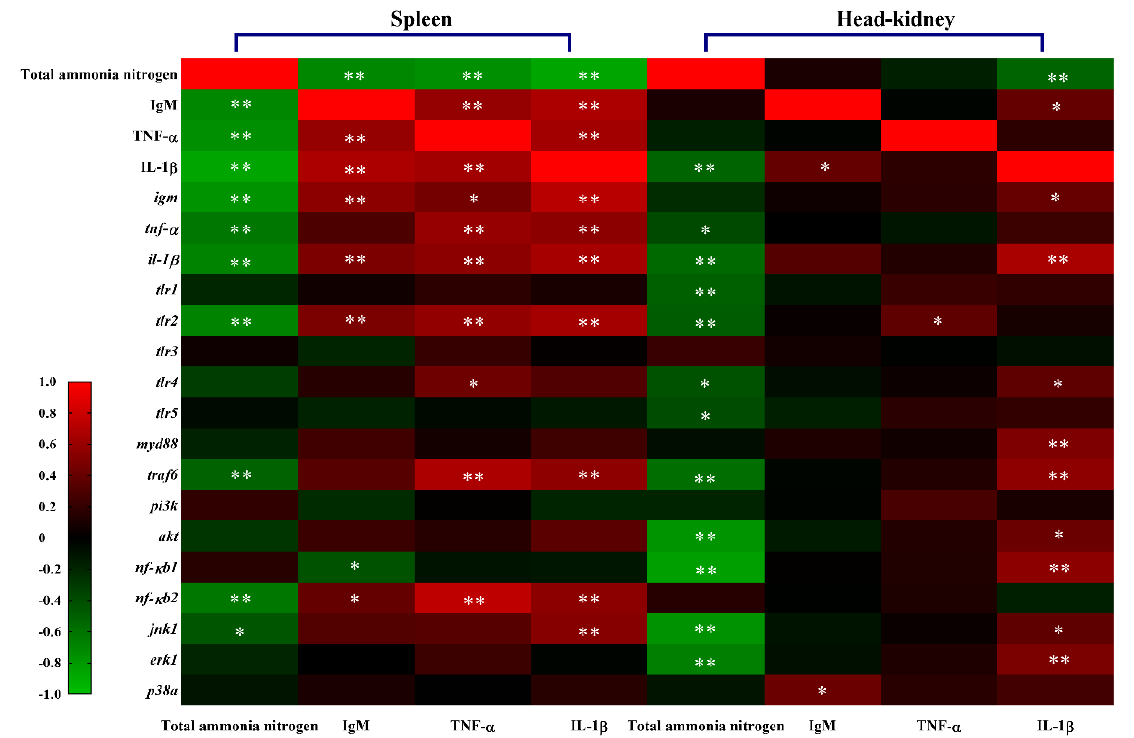
Figure 7. Spearman correlation coefficients ® among ammonia exposure concentration and immune parameters involved with TLR signaling pathway in the spleen and head-kidney of M. amblycephala following chronic ammonia exposure. The values of p < 0.05 and 0.01 are represented as “*” and “**” above the column, indicating significant difference versus control, respectively.